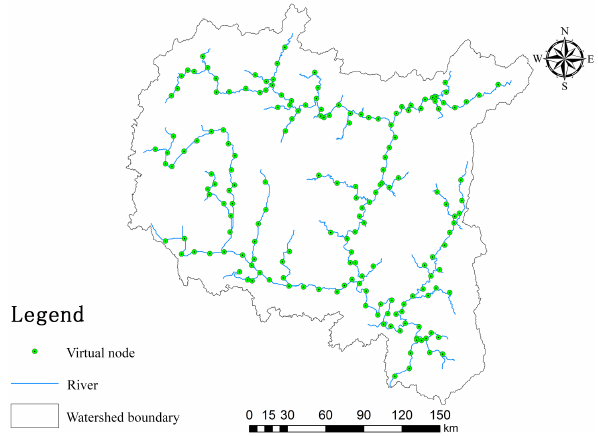
Figure 3. Liuxihe model structure setup for LRB (200m × 200m resolution).